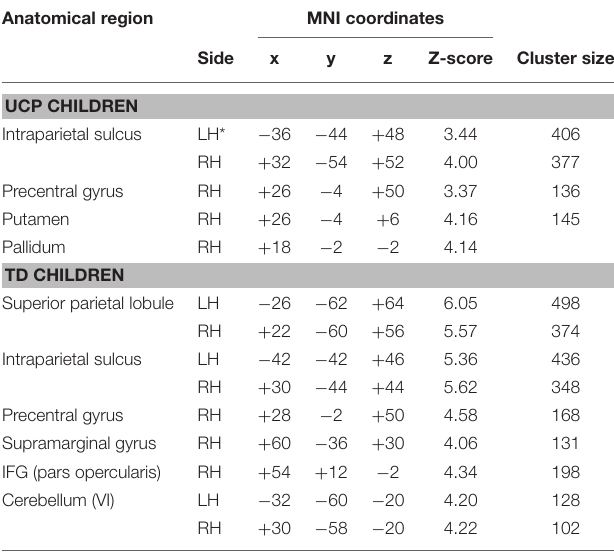
TABLE 3 | MNI coordinates and statistical details for brain areas showing a positive correlation with the MIA score obtained by UCP children in the mental chronometry